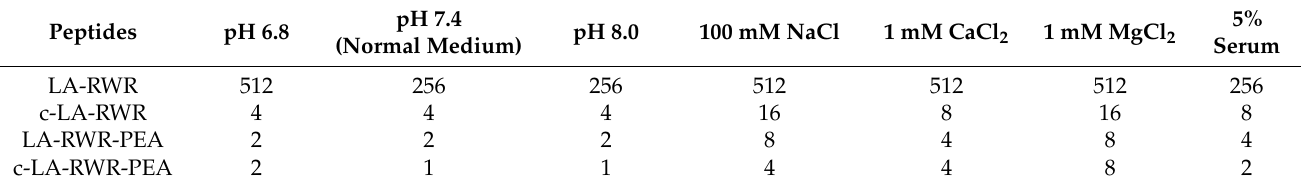
Table 2. Effects of pH, salt, and serum on antibacterial activities (in µ g/mL) of LA-RWR,